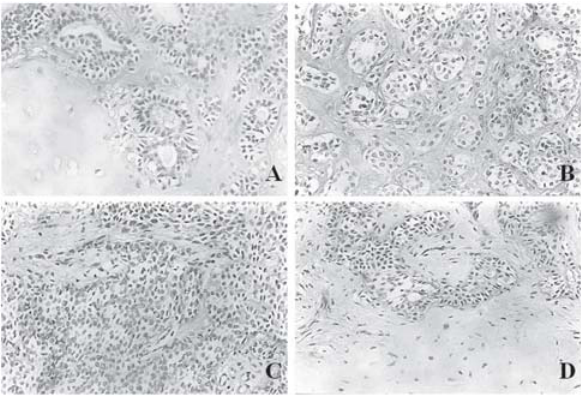
Figure 1(A)- Pleomorphic adenoma in major salivary gland. Immunostaining for tenascin in the chondroid stroma (streptavidin-biotin complex; original magnification X200); (B). Minor salivary gland. Positive staining for tenascin in the fibrous stroma (streptavidin-biotin complex; original magnification X200); (C). Major salivary gland. Strong expression for fibronectin in the fibrous stroma and around polygonal cells nests (streptavidin-biotin complex; original magnification X200);(D). Minor salivary gland. Strong expression for fibronectin around epithelial cells nests and adjacent to the chondroid area (streptavidin-biotin complex; original magnification